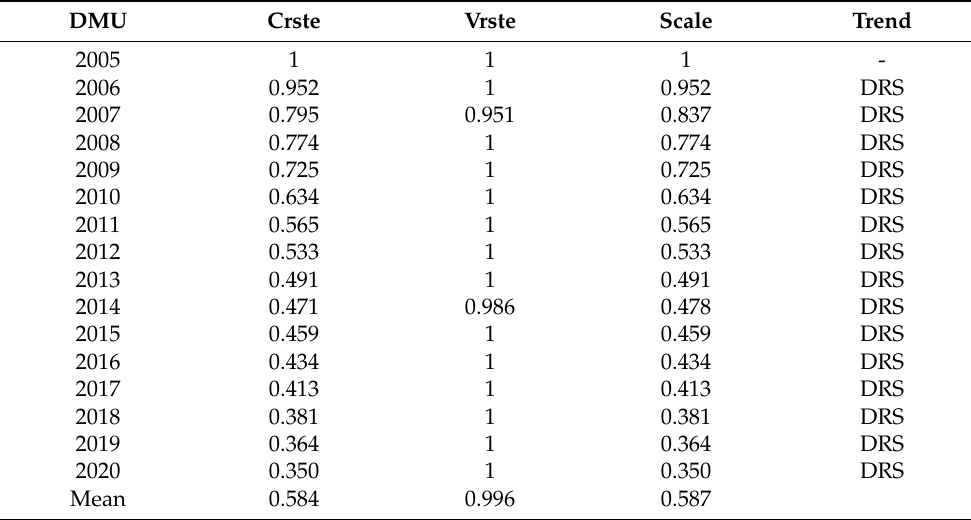
Table 6. Measurement results of China’s wind power utilization